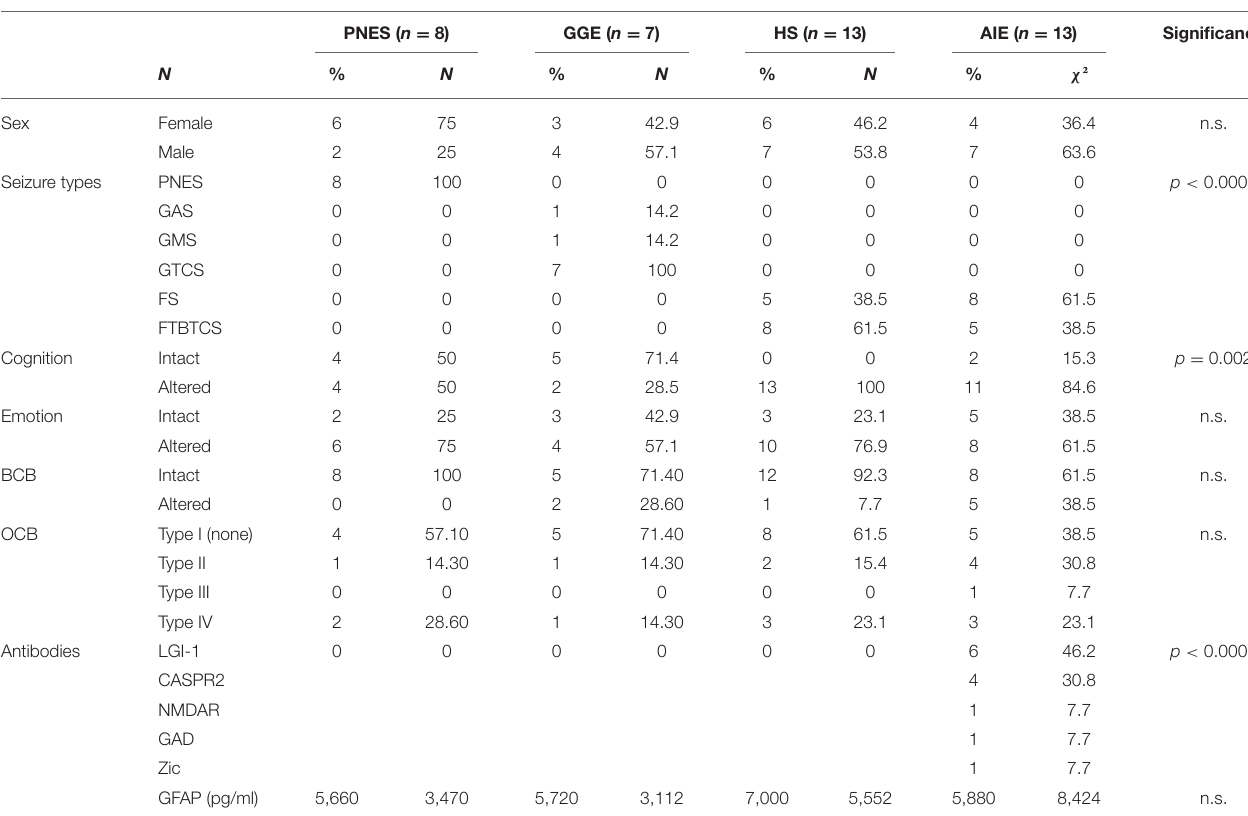
TABLE 1 | Clinical characteristics (categorical).